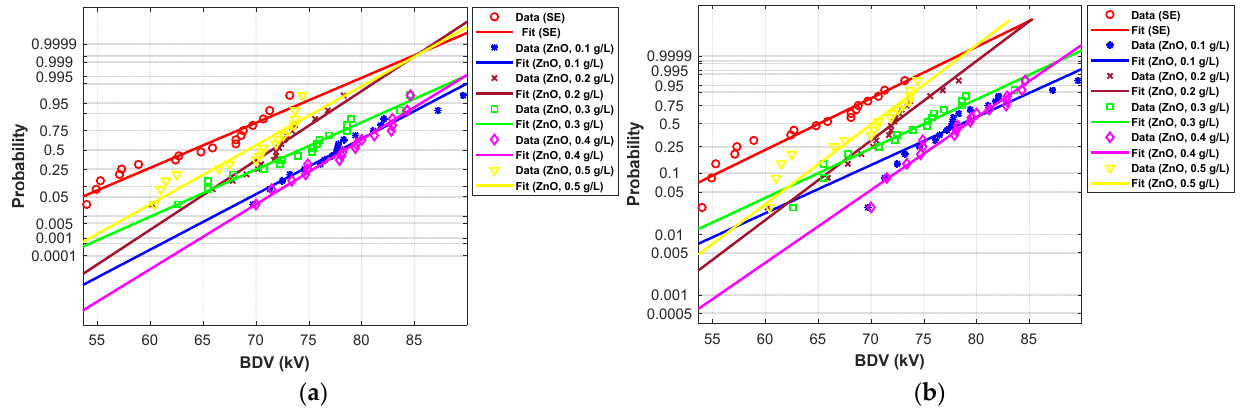
Figure 12. Probability plot of breakdown voltage data of SE-based nanofluids with ZnO (25 nm) for 2 mm electrode gap; ( a ) normal and ( b ) extreme value.